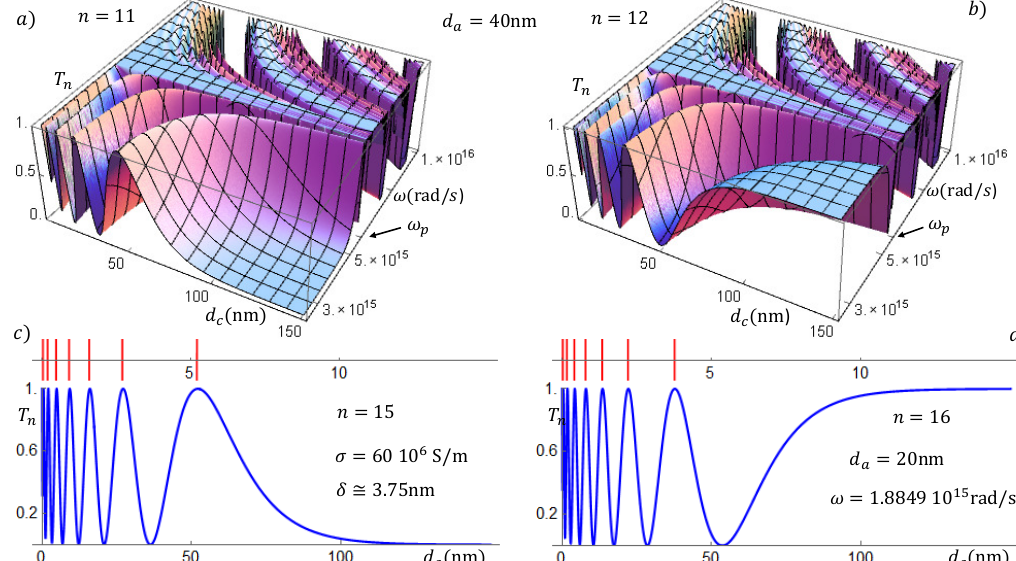
Figure 6. Transmittance through ( air / silver / air ) n SLs as a function of the frequency ω and the conductor-layer width d c . In ( a ) and ( c ), the number of unit cells n is odd, while in ( b ) and ( d ), it is even. The difference in the behavior of T n below and above ω p can be seen much clearly in the upper panels. The line shapes of resonant plasmons with ω > ω p are thinner, therefore more localized, than at low frequencies. We assume that this is a result from a complex coupling of interface plasmons. A parity effect is also clear for d c larger than ∼ 50nm. At larger conductor widths, the low frequency transmission either vanishes, for n odd, or tends asymptotically to one, for n even. In the lower-panel graphs, we plot, together with the transmission coefficient, the dispersion relation of Equation (23), and we see that, if n is odd, the number of plasmon resonances is the same for SLs with n and with n + 1 unit